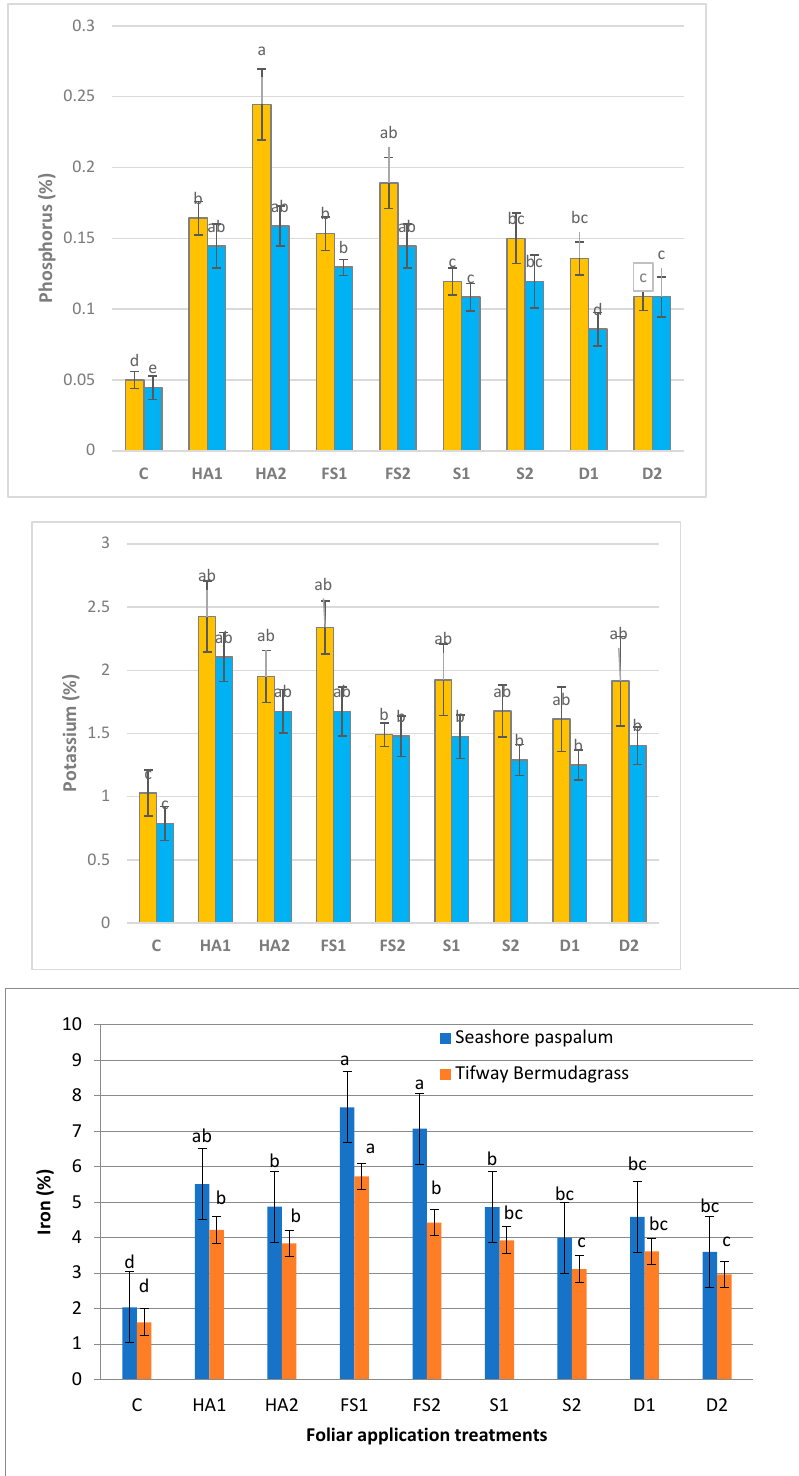
Figure 5. Mean leaf content of nitrogen (%), phosphorus (%), potassium (%) and iron (mg kg − 1 ) ± SE in seashore paspalum (orange bars) and Tifway bermudagrass (blue bars) treated with different amendments; values represent a mean of the two seasons. C = control, HA = humic acid, FS = ferrous sulphate, S = silica, D = diatomite. For more details about the treatments, please refer to Table 1. Data are presented as mean value ± standard error of the mean, with the letter(s) from the species-wise Duncan’s multiple range tests indicated above each bar.